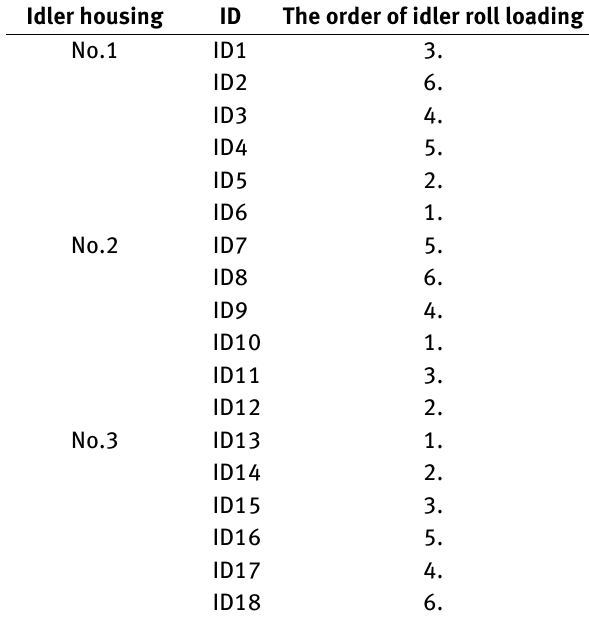
Table 4: The order of idler roll loading in each idler housings Idler